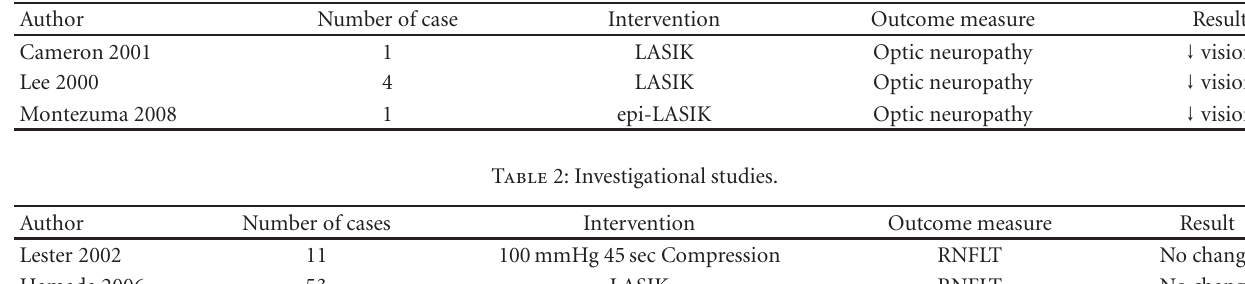
Table 1: Case reports.